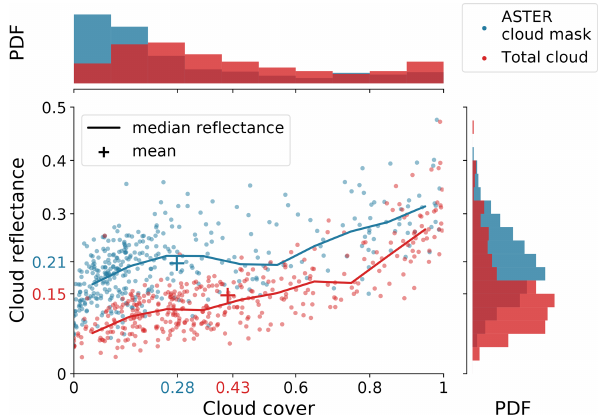
Figure 10. Expected cloud reflectance corresponding to the ASTER cloud mask (blue) and the derived total cloud cover (red) from 380 ASTER images. The median cloud reflectances are given by the lines, and the dataset averages are visualized by the + marker and the respectively colored tick labels. The frequency distributions of cloud cover and cloud reflectance are shown on the top and right,